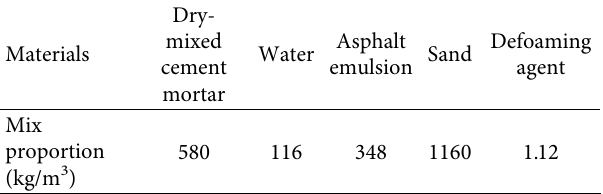
Table 3: Mix proportion of the CA